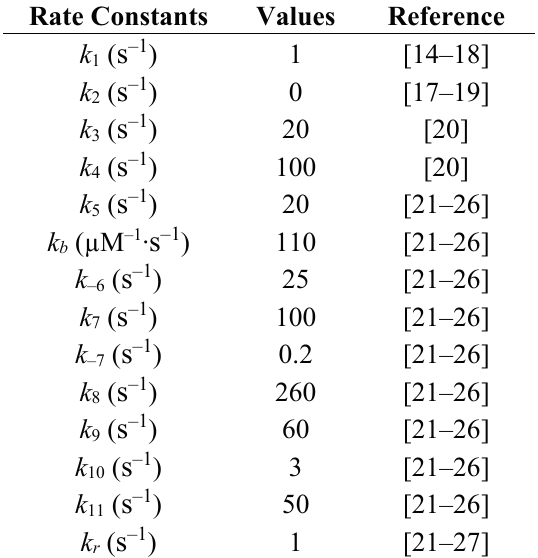
Table 1. In vitro values of rate constants defined in Figure 9 for the Escherichia coli ribosome. Rate Constants Values Reference